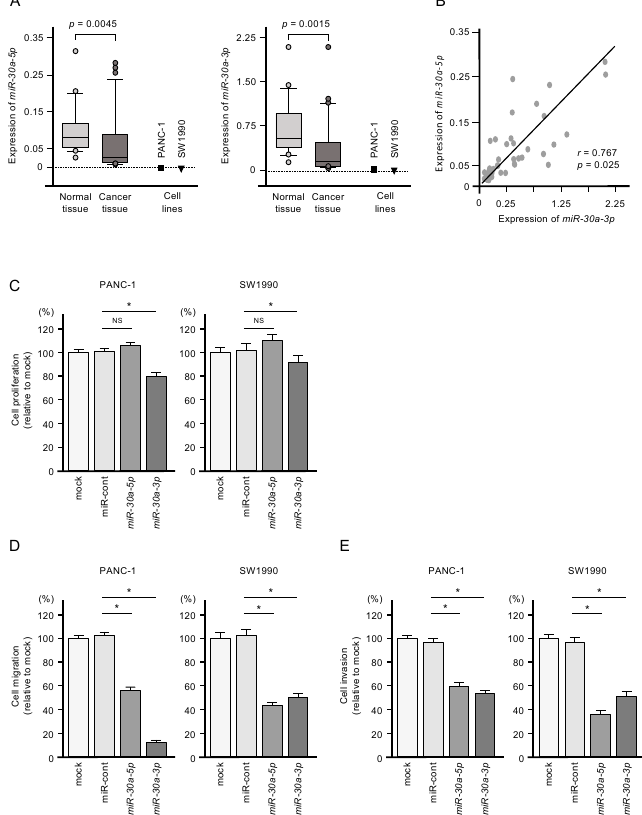
Figure 1. Tumor-suppressive functions of miR-30a-5p and miR-30a-3p in pancreatic ductal adenocarcinoma (PDAC) cells. ( A ) Expression levels of miR-30a-5p and miR-30a-3p in PDAC clinical specimens and cell lines (PANC-1 and SW1990). Data were normalized relative to the expression of RNU48. ( B ) Pearson’s coe ffi cient showed positive correlations between the expression levels of miR-30a-5p and miR-30a-3p in clinical specimens. ( C ) Cell proliferation assessed using XTT assays. Data were collected 72 h after miRNA transfection (* p < 0.0001). ( D ) Cell migration assessed with a membrane culture system. Data were collected 48 h after seeding the cells into the chambers (* p textless 0.0001). ( E ) Cell invasion determined using Matrigel invasion assays conducted 48 h after the seeding of the miRNA-transfected cells into the chambers (* p <